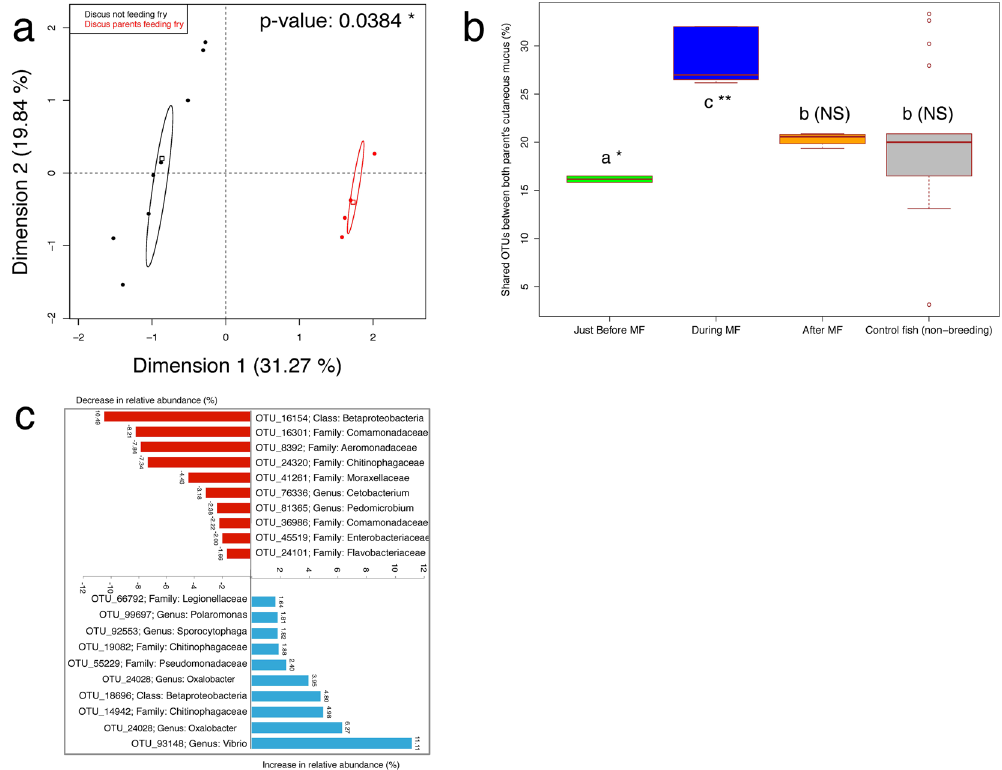
Figure 4. Taxonomic shift towards a core skin mucus microbiota on parents rearing fry. In ( a ) Multi- Factorial Analysis (MFA) based on the variations of relative abundance of bacterial taxa (identified at the lowest taxonomic level possible) in regards of the reproductive status of the discus: breeding or not-breeding. Confidence ellipses highlight significant differences at a 0.95 confidence threshold. In ( b ) boxplots representing the percentage of shared OTUs between both parents of the breeding couple before mucus feeding (MF), during mucus feeding, after mucus feeding, and between 20 random couples of non-breeding control fish. In ( c ) analysis of the taxonomic shifts that occurred in the skin mucus microbiota of parents when getting into reproduction phase. Red bars represent a decrease while blue bars represent an increase (in % of relative abundance). Each OTU was labeled at the lowest taxonomic level